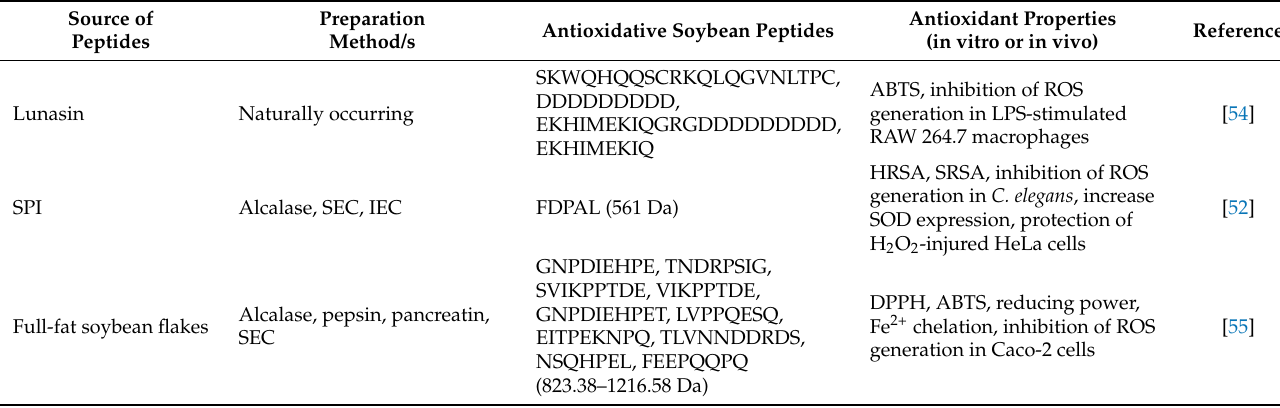
Table 1. Antioxidant properties of soybean-derived hydrolysates and peptides. Source of